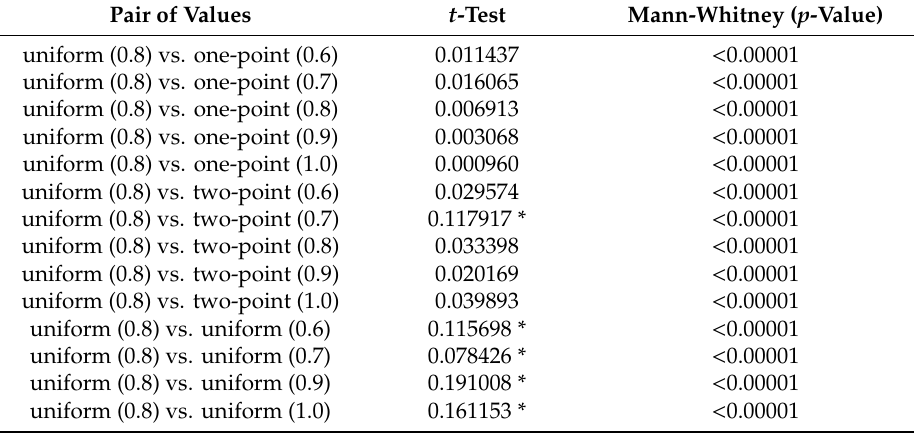
Table 6. Statistical comparison between the uniform with a 0.8 and the